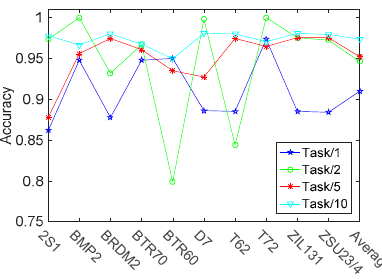
Figure 8. The recognition rates of ten vehicles with different learning methods. The term ‘Task/1’ denotes that each of the ten modes (classifiers) is individually learned (trained). While the term l ‘Task/2’ (‘Task/5’, ‘Task/10’) means that every two (five, ten) modes are jointly learned.